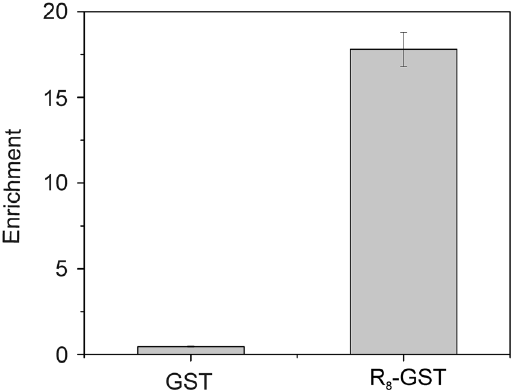
Figure 3. Analysis of 24–10 aptamer specificity using qPCR. The enrichment was expressed as the ratio: binding of tested aptamer/binding of reference aptamer to GST or R 8 -GST. Results are the mean of three measurements. Error bars represent the standard